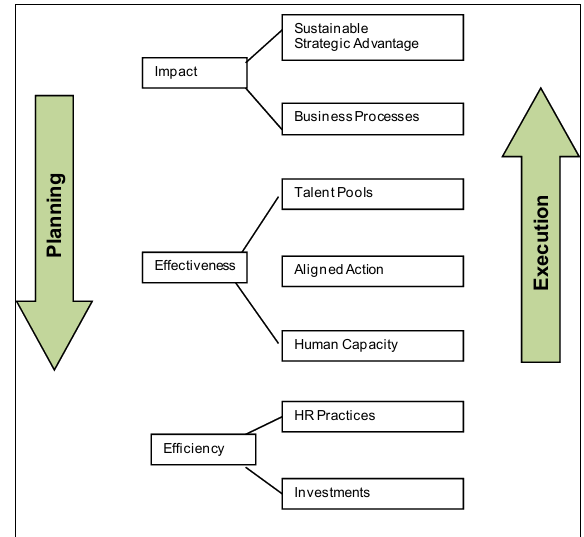
FIGURE 1 HC BRidge TM